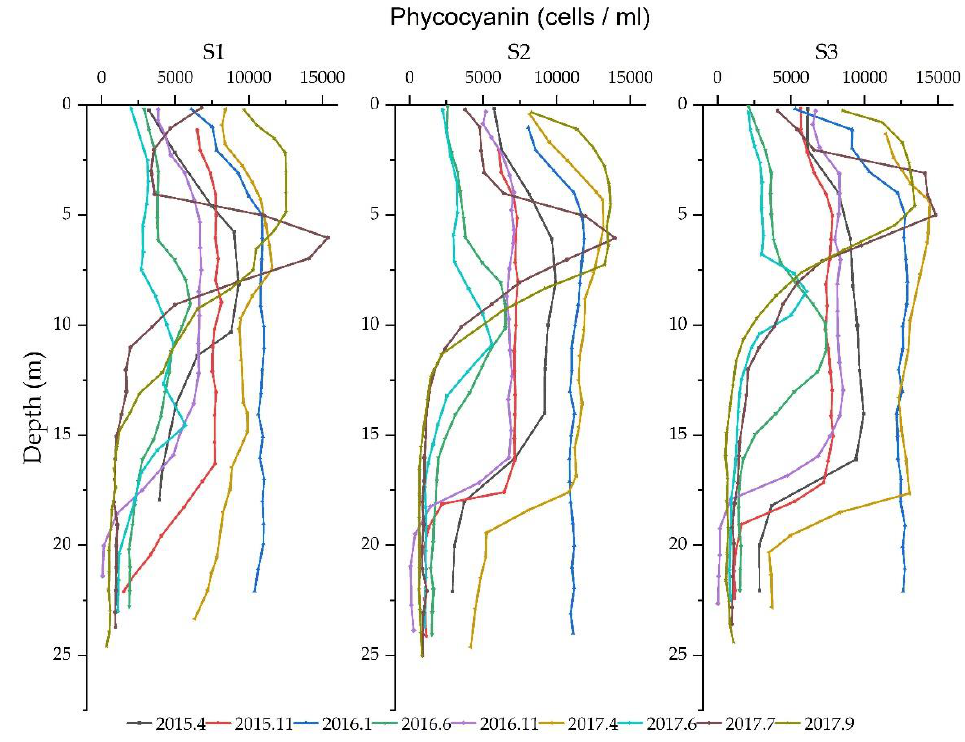
Figure 7. Vertical profile of phycocyanin in Lake Yangzong.